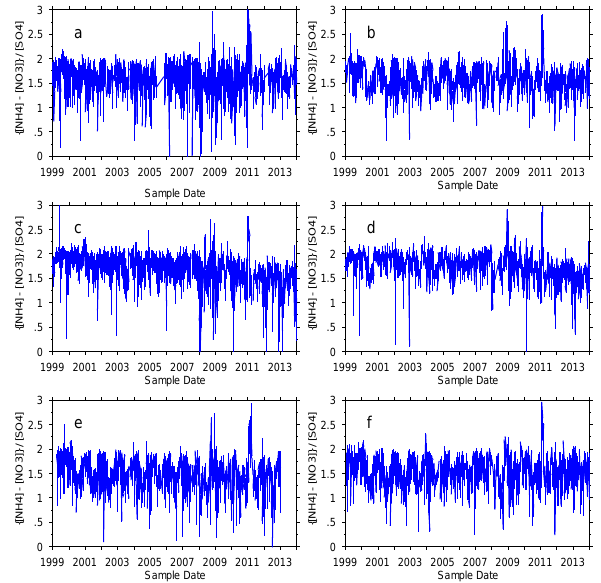
Figure 5. Daily molar ratio of {[NH 4 ] – [NO 3 ]} / {[SO 4 ]} (sulfate BHM, (b) CTR, (c) JST, (d) YRK, (e) GFP, and (f) OLF. The ratios decreased 1514 neutralization) at (a) BHM, (b) CTR, (c) JST, (d) YRK, (e) GFP, by 0.01 - 0.03 units yr -1 (statistically significant at all sites, p < 0.0001) and 1515 and (f) OLF. The ratios decreased by 0.01–0.03unitsyr − 1 (statis- averaged 1.5 (GFP, OAK) to 1.8 (JST, YRK) over the study period. A seasonal 1516 tically significant at all sites, p < 0 . 0001) and averaged 1.5 (GFP, variation in the ratio is seen especially at CTR from 2001-2007, where the ratio 1517 OAK) to 1.8 (JST, YRK) over the study period. A seasonal variation in the ratio is seen especially at CTR from 2001 to 2007, where the ratio is reduced in summer relative to